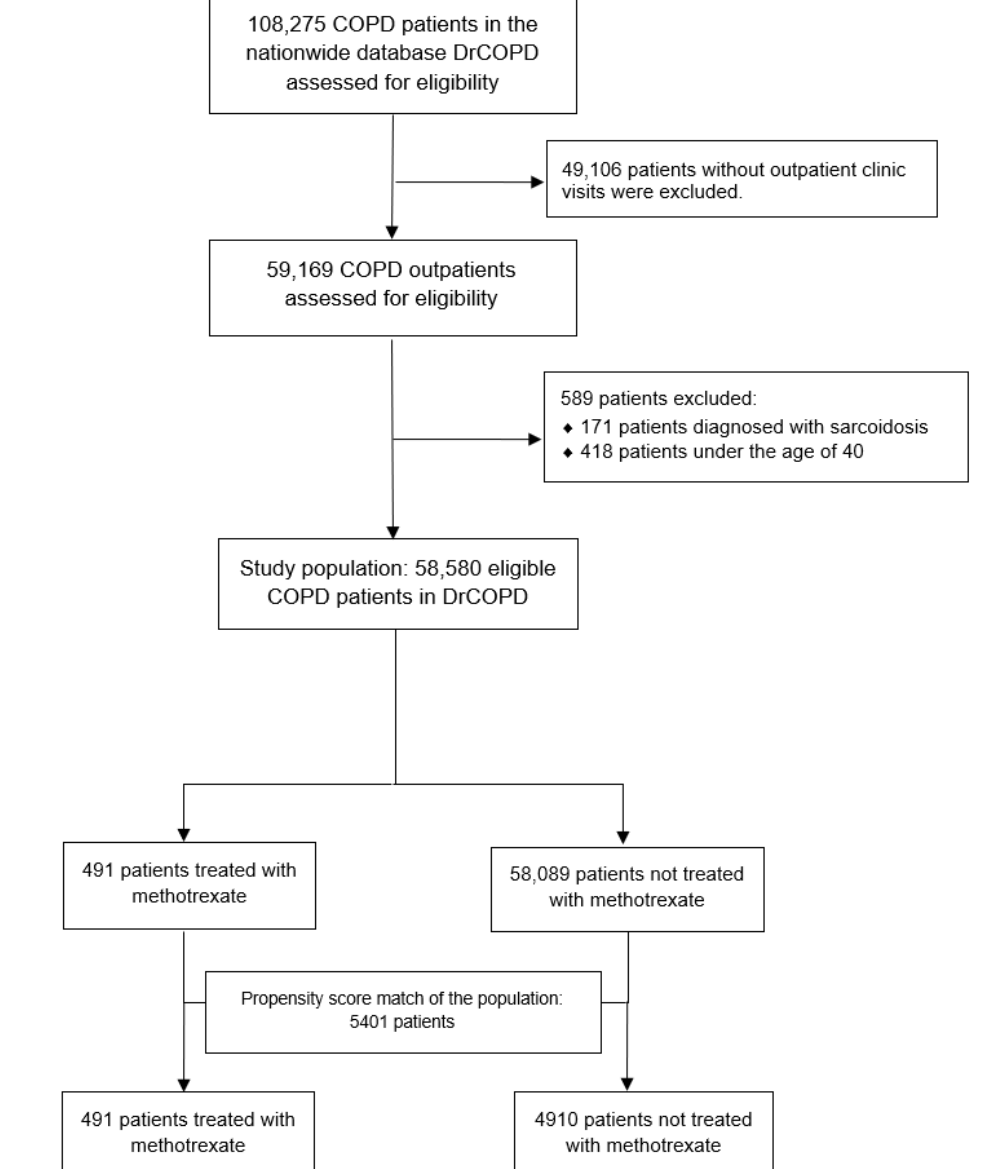
Figure 1. Study flowchart. 58,580 eligible patients registered with COPD in DrCOPD from 1 January 2010 to 31 December 2017 were included in our study. Abbreviations: COPD, Chronic Obstructive Pulmonary Disease; DrCOPD, The Danish Registry of Chronic Obstructive Pulmonary Disease. Table 1. The demographic and clinical characteristics of our study population.